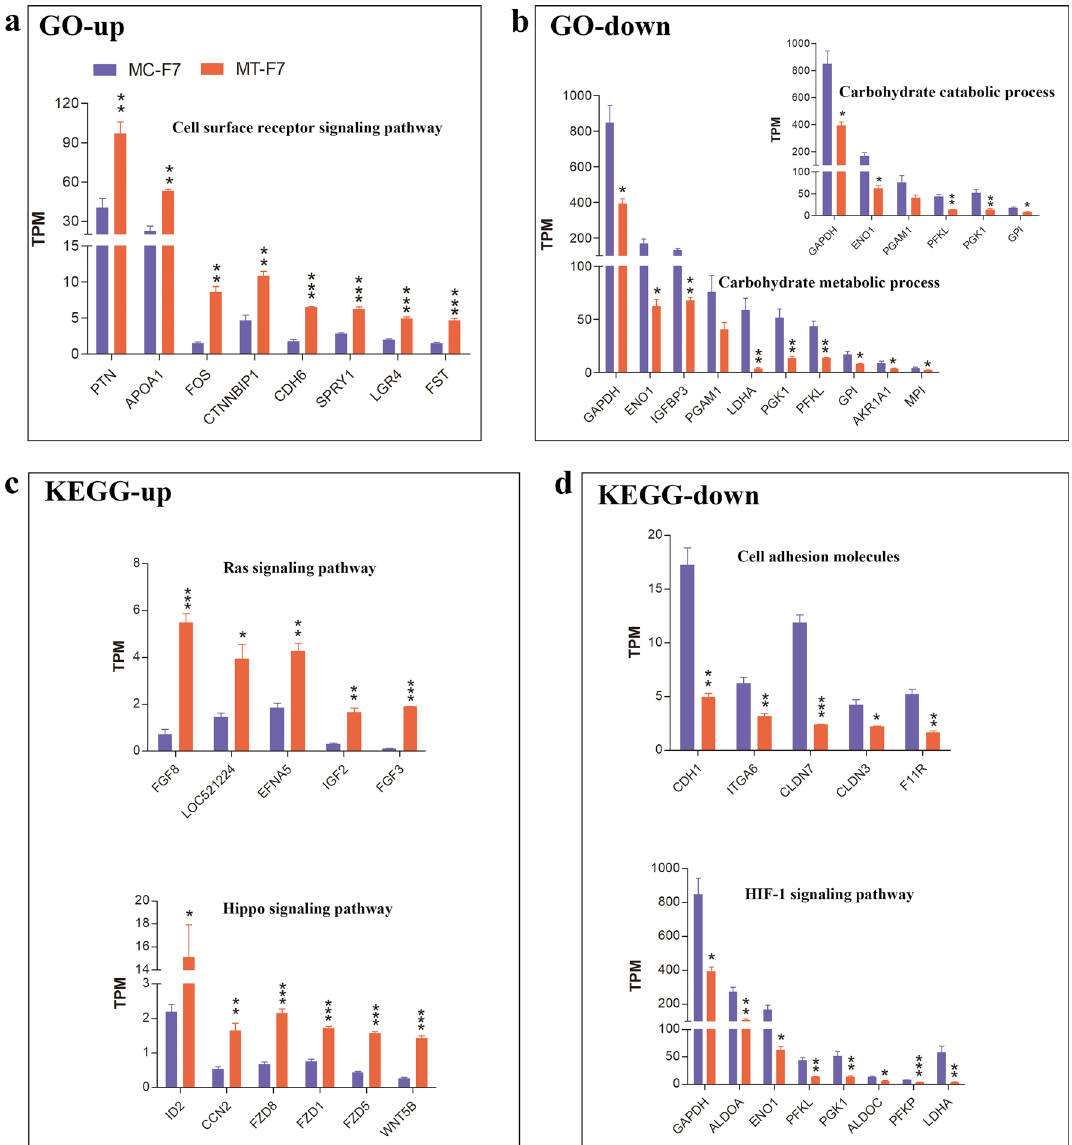
Figure 5. Functional enrichment analysis of differentially expressed genes in MT-F7 cells. The list shows top 5–10 genes with high transcript levels in each of the enriched GO terms or KEGG pathways based on the DEGs between MT-F7 and MC-F7 cells. ( a ) The cell surface receptor signaling pathway (GO up) is upregulated in the MT-F7 cells. ( b ) The carbohydrate metabolic process and carbohydrate catabolic process (GO down) is downregulated in the MT-F7 cells. ( c ) Ras and Hippo signaling pathways (KEGG up) are upregulated in the MT-F7 cells. ( d ) Cell adhesion genes (KEGG down) are downregulated in the MT-F7